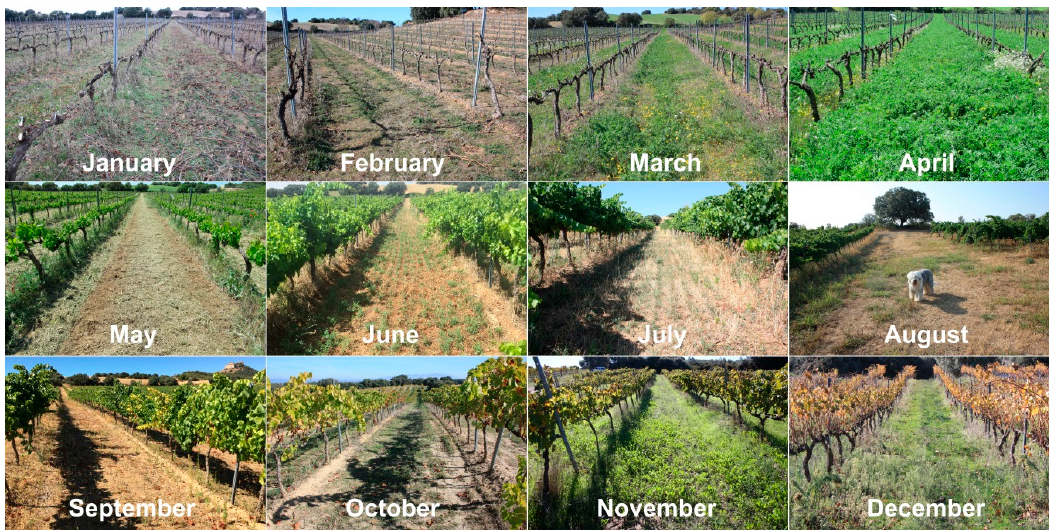
Figure 3. Temporal changes in the canopy cover of the grapevines and the cover crop of common sainfoin over the twelve months of the year.